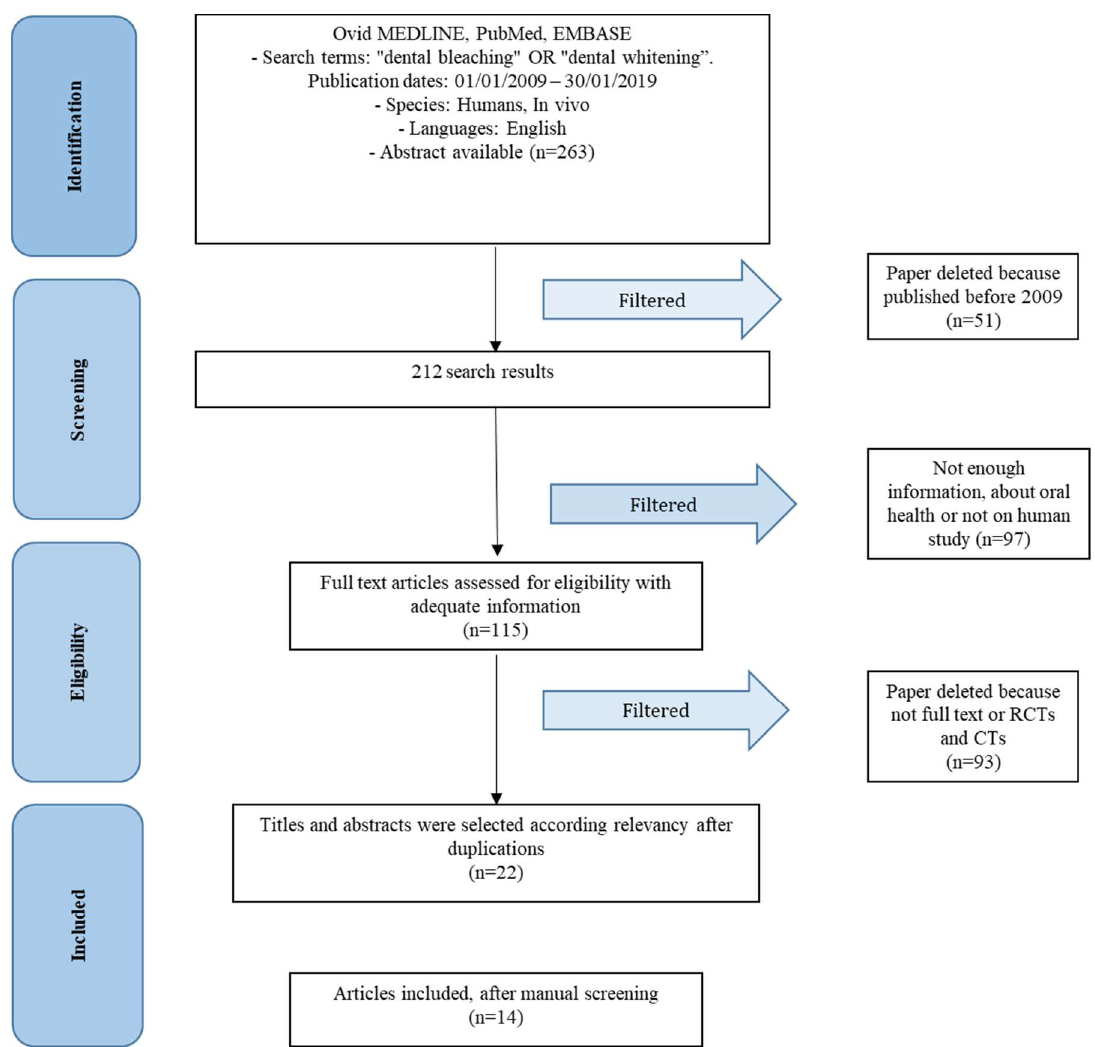
Figure 3. PRISMA flow chart.